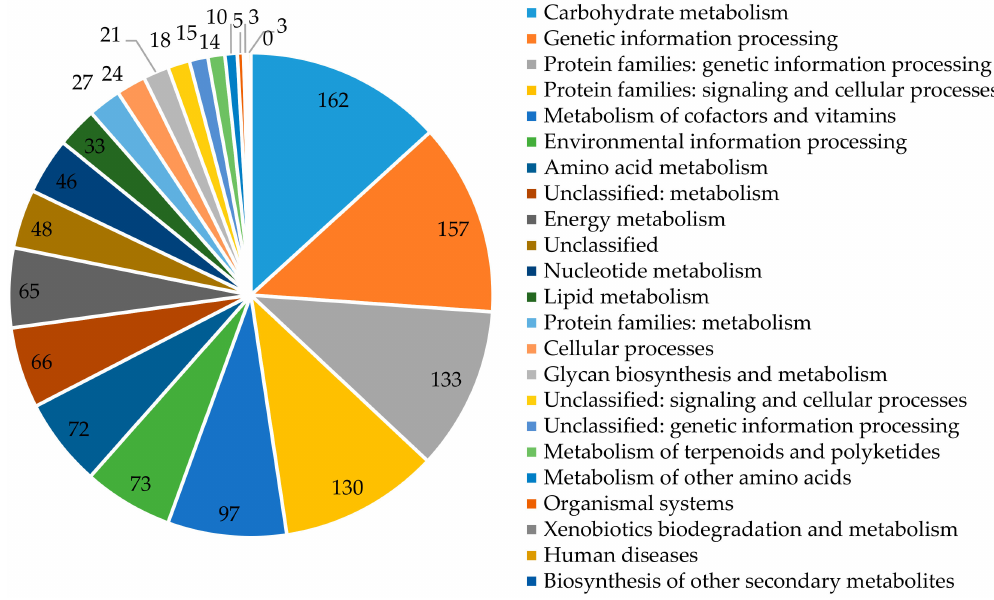
Figure 2. The number of genes assigned in KEGG